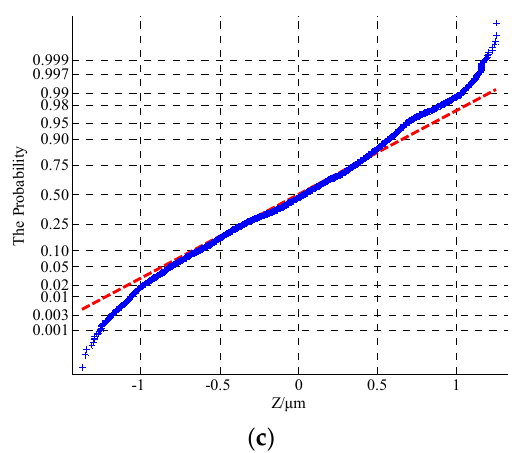
Figure 12. The probability density for different D and G : ( a ) D = 1.5, G = 0.12; (b) D = 1.7, G = 0.12; ( c ) D = 1.5, G = 0.52.